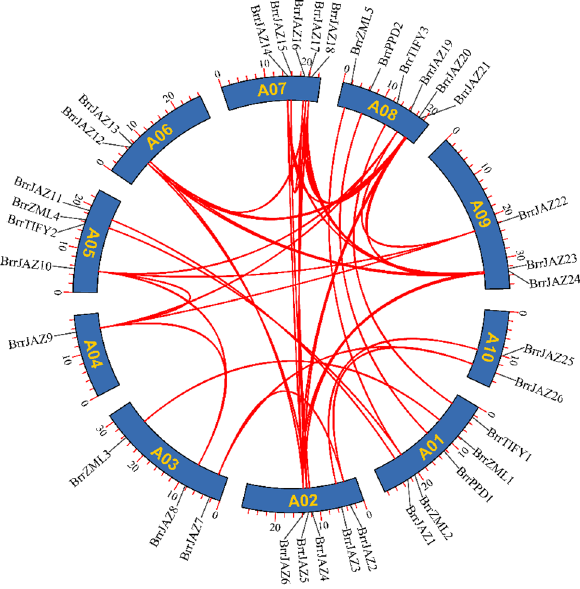
Figure 5. Collinearity analysis of BrrJAZ family genes. Red lines indicate duplicated JAZ gene pairs in the turnip